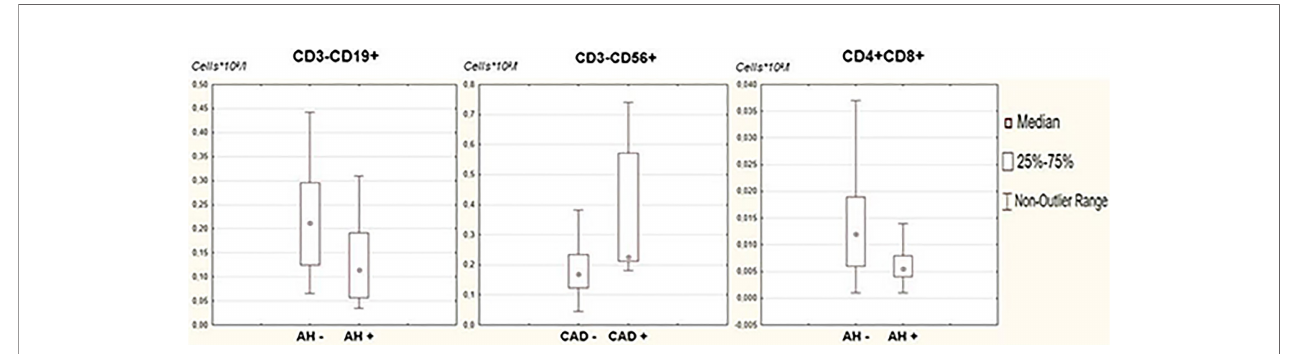
FIGURE 3 | Comparative analysis of lymphocyte subpopulations in patients with associated clinical conditions. Clinical conditions associated with metabolic syndrome - arterial hypertension, overweight, hypercholesterolemia, diabetes mellitus, coronary and cerebral artery disease - were assessed in the study group. For all examined subjects, lymphocyte subpopulations were assessed by fl ow cytometry. A comparative analysis of lymphocyte subpopulations in patients in the studied groups was carried out; statistical analysis was carried out using the Mann-Whitney